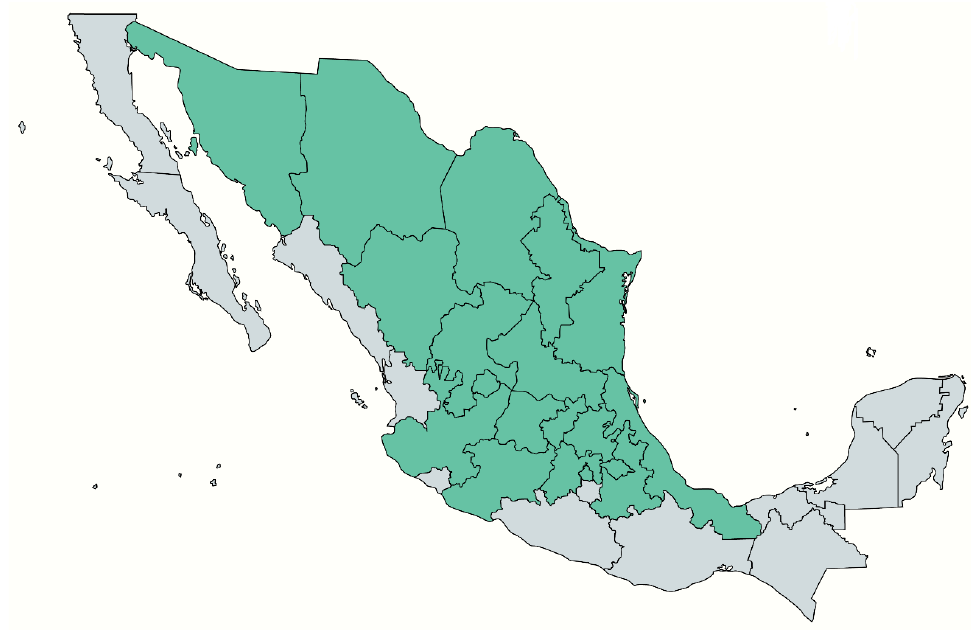
Figure 2. Geographical distribution of Sphaeralcea angustifolia species in Mexico.